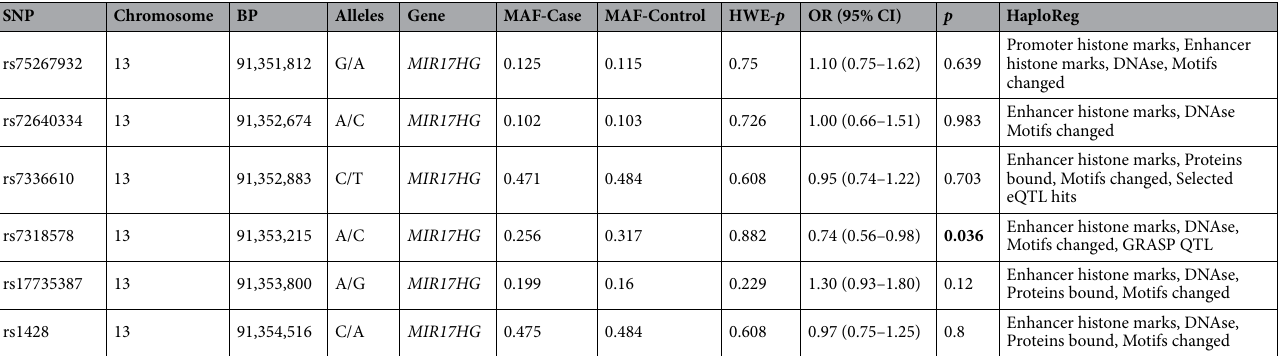
Table 2. Basic information of six SNPs on the MIR17HG gene in this study. HWE Hardy–Weinberg equilibrium, ORs odds ratios, CI confidence interval. p < 0.05 indicates statistical significance. Significant values are in bold.